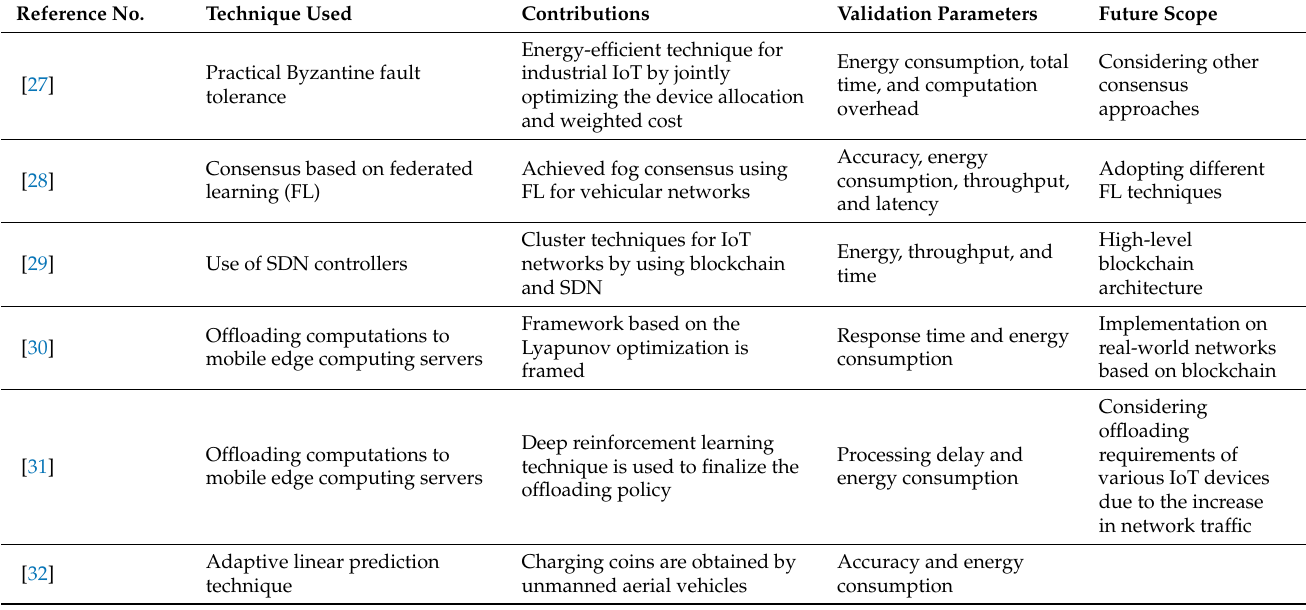
Table 2. Related work on improving energy